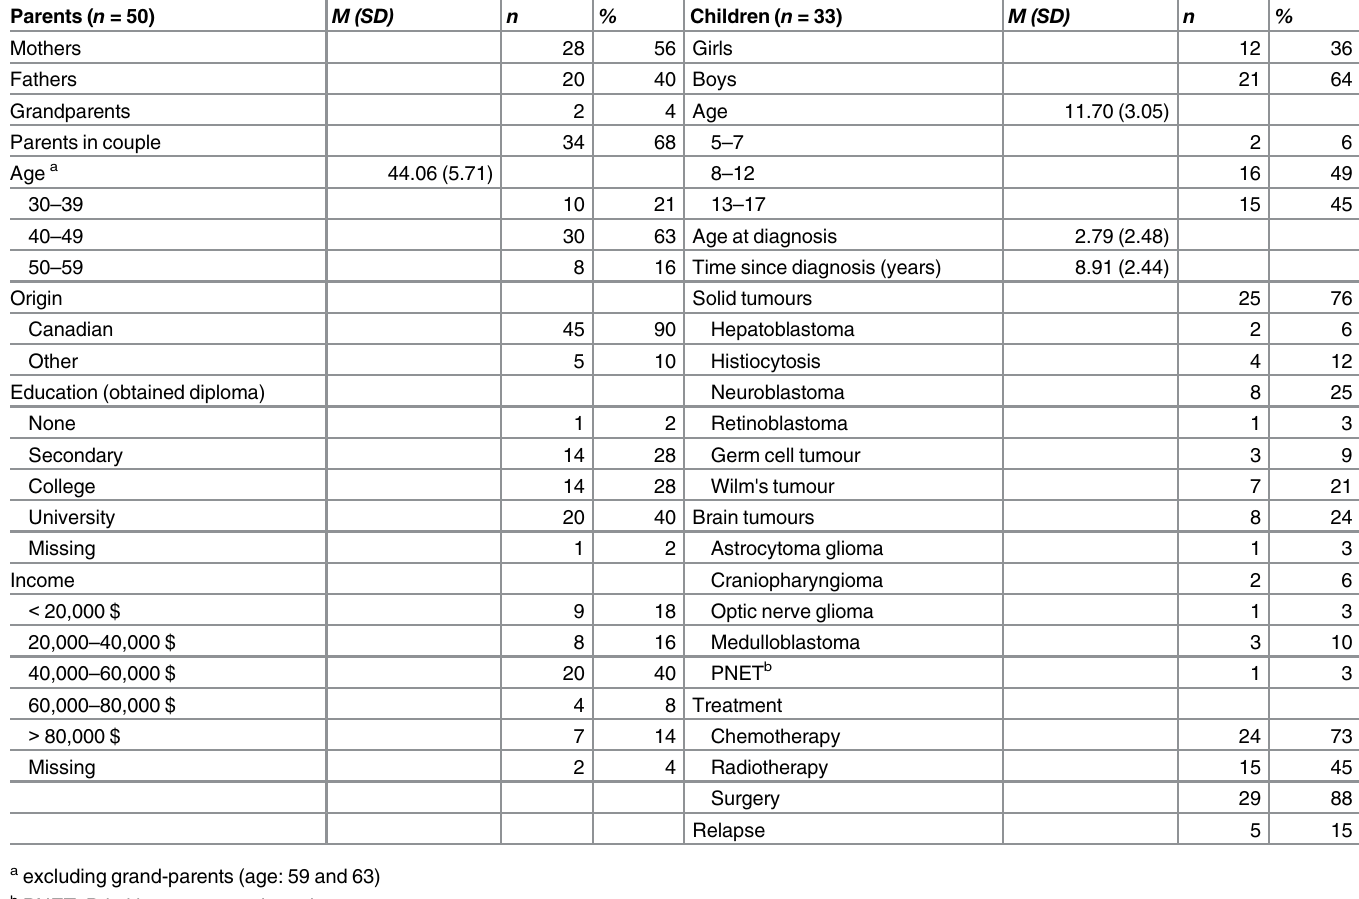
Table 1. Demographic